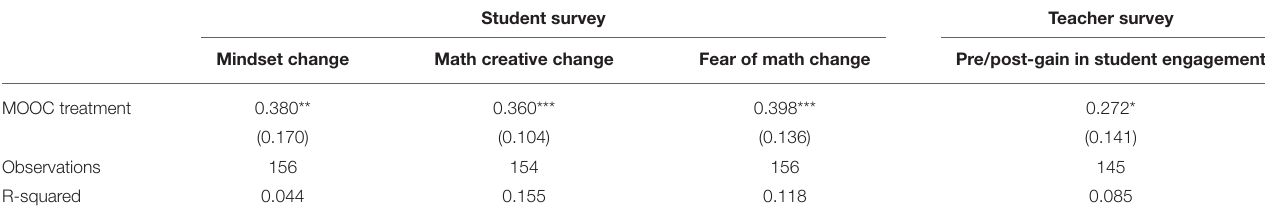
TABLE 8 | Regression estimates, MOOC effect on student mindset surveys.